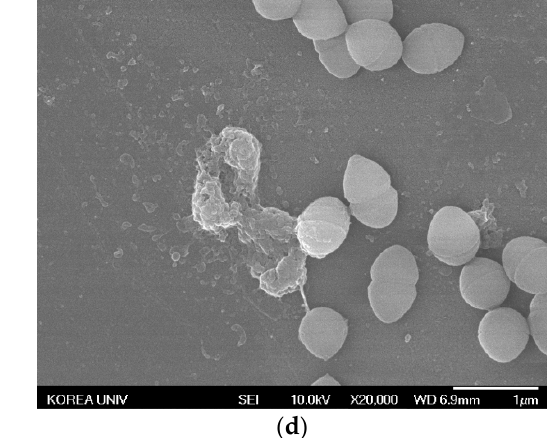
( d ) Figure 9. SEM images of MRPA treated with AgNPs. ( a ) Negative control magnified 3000×. ( b ) Negative control magnified 20,000×. ( c ) AgNP-treated MRPA magnified 3000×. ( d ) AgNP-treated MRPA magnified 20,000×.